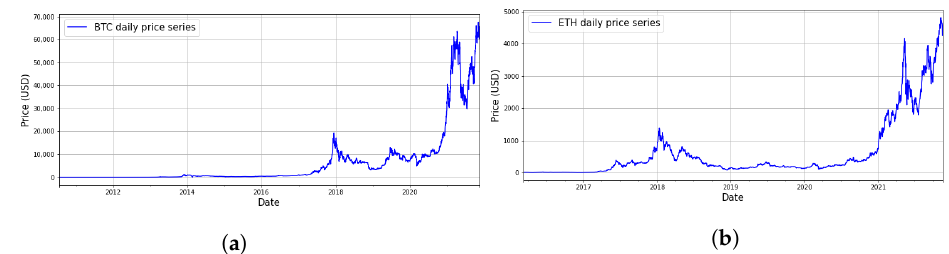
Figure 3. Daily market price (source: investing.com, accessed on 16 November 2021). ( a ) Bitcoin (BTC). ( b ) Ethereum (ETH). Table 4. Key Bitcoin and Ethereum